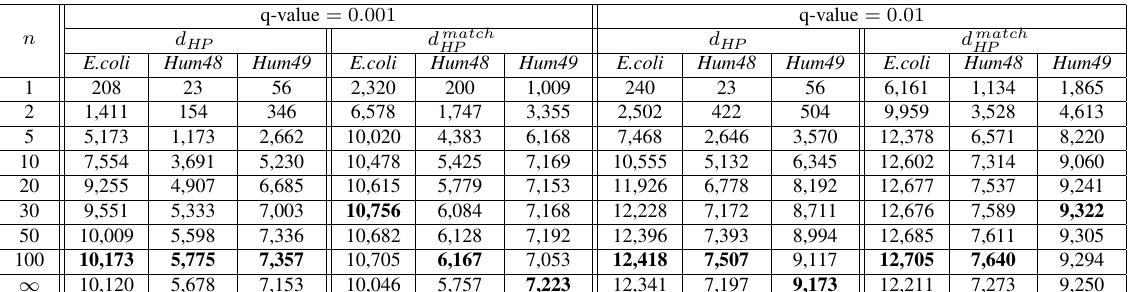
Table 2: Numbers of peptides identified by d HP and d match best result in each column is